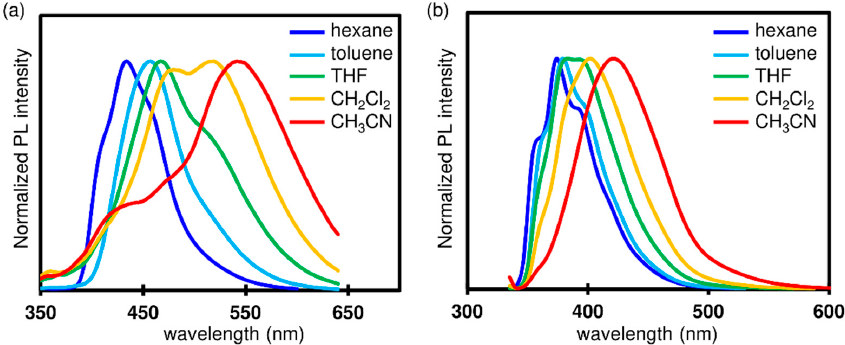
Figure 4. Solvent effect on PL spectra of ( a ) rac - 2 and ( b ) rac - 3 .